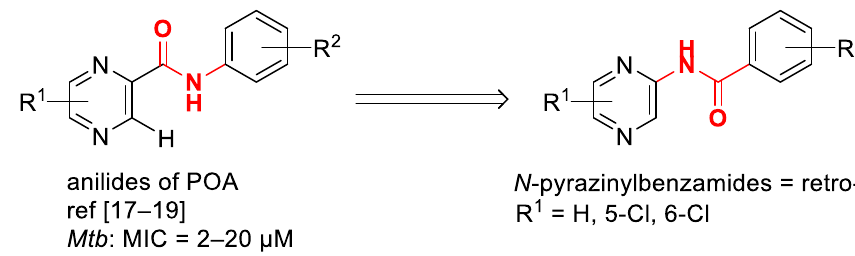
Figure 1. Design of title compounds inspired by previously published N- phenylpyrazine-2- carboxamides with antimycobacterial